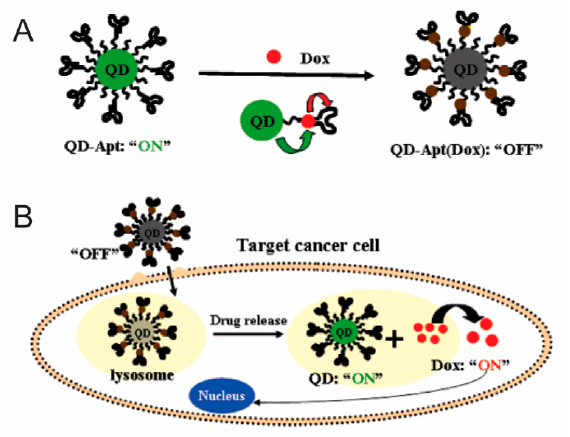
Figure 2. ( A ) Schematic illustration demonstrating the Bi-FRET-based QD-aptamer-doxorubicin nanoparticle. This approach results in the simultaneous quenching of QD and doxorubicin; QD fluorescence is quenched by doxorubicin while doxorubicin fluorescence is quenched by QD. ( B ) Schematic illustration depicting the internalization via the PSMA endocytosis pathway. Internalization results in the release of doxorubicin from the conjugated nanoparticle, thereby